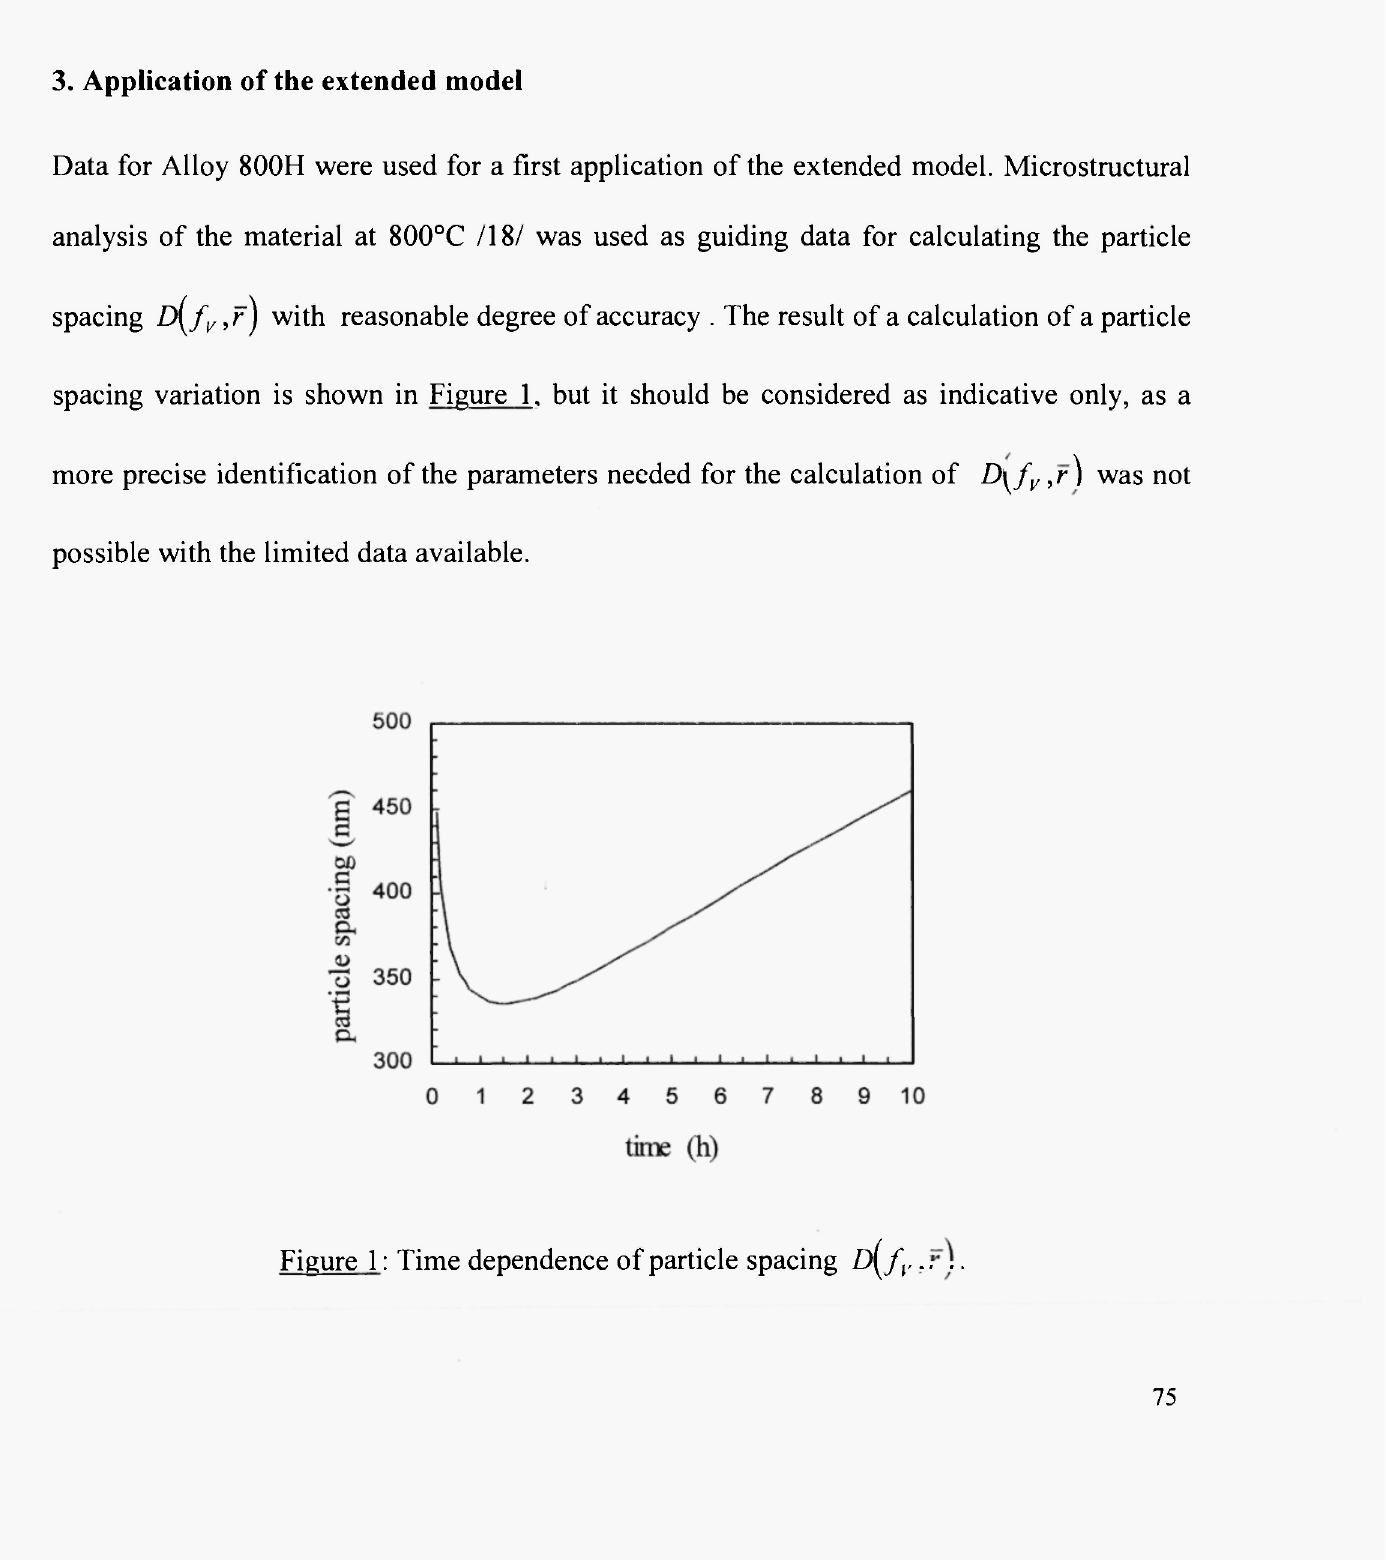
Figure 1: Time dependence of particle spacing £)(/,,